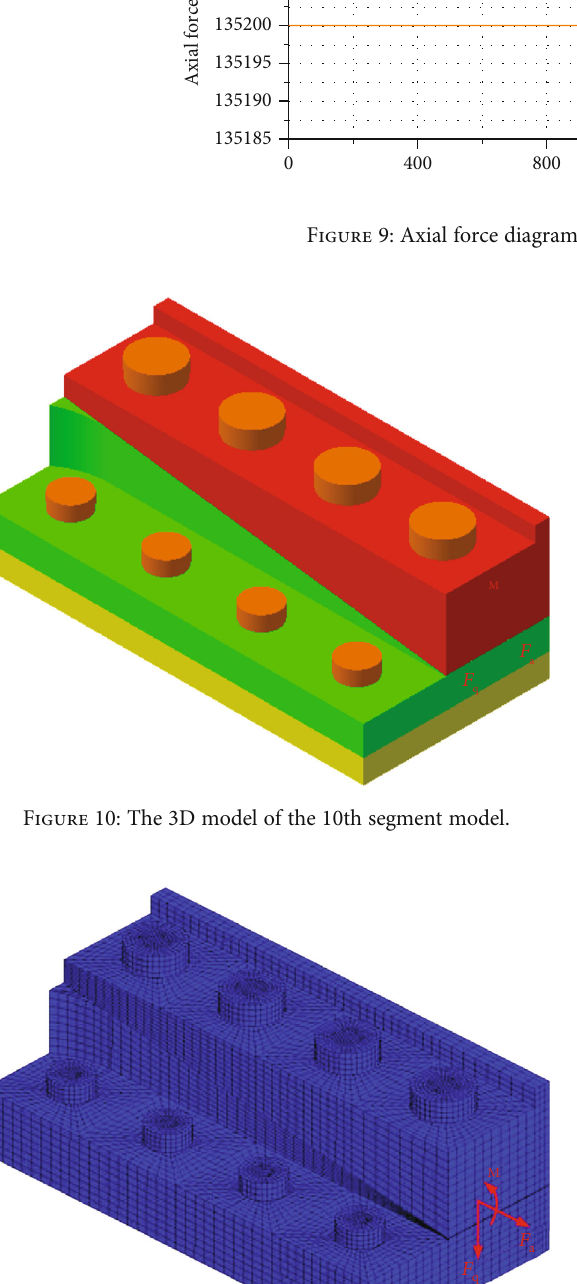
Force of the second row of bolts: P 2 = F b ‐ b − F c ‐ c . Force of the third row of bolts: P 3 = F c ‐ c − F d ‐ d . Force of the fourth row of bolts: P 4 = F d ‐ d − F e ‐ e . F